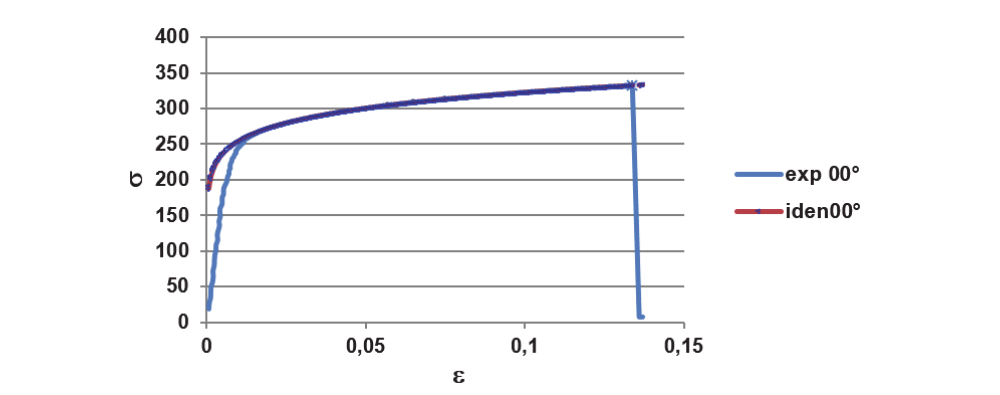
Figure 1: Identification of the hardening curve :  = 00°.